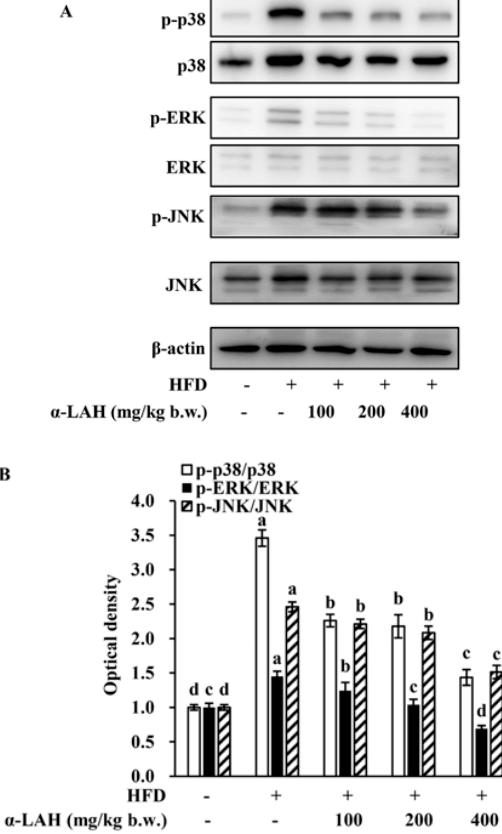
Figure 7. Effect of bovine α -lactalbumin hydrolysates ( α -LAH) supplementation on the activation of mitogen activated protein kinase (MAPK) signaling pathway in epididymal adipose tissues of mice fed with high-fat diet. ( A ) A representative image of western blot analysis for p-p38, phospho-extracellular signal regulated kinases (p-ERK) and phospho-Jun N-terminal kinases (p-JNK) in epididymal adipose tissues; ( B ) fold change in relative densitometric levels of p-p38/ p38, p-ERK/ERK and p-JNK/JNK relative to the ND group. All data were presented as means ± standard deviations (SD) ( n = 6). Significance was determined by one-way analysis of variance (ANOVA) with the Duncan’s multiple-comparison test, and mean values without common letters indicate differences at p < 0.05.